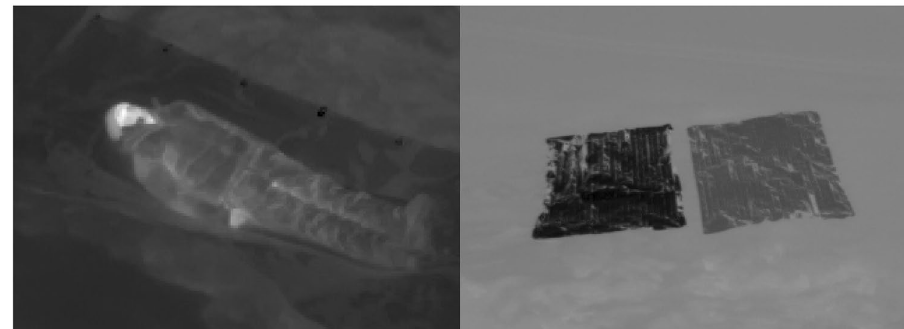
Table 1 Thermo-radiation measurements of body temperature through various types of textile clothing with a thermal camera at distances of 50 m (median body-air gradient: 38.3 °C at air temper- atures: −1.3 to -2.5 °C; humidity: 62.3 to 77.1%) and 5 m (body-air gradient: 41.2 °C at air temperatures: −4.4 to −5.3 °C; humidity: 87.0 to 91.5%)